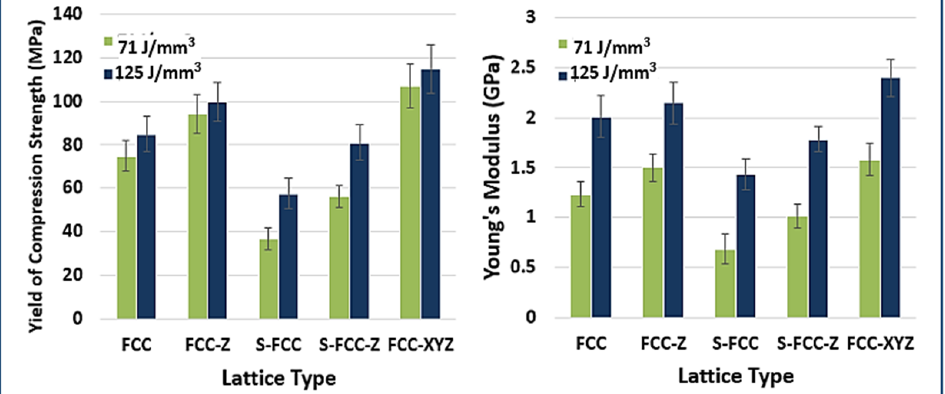
Figure 15. The compression properties of SLMed objects with five types of lattice structures, yield strength at 0.02 offset from the first plateau start, and Young’s modulus.